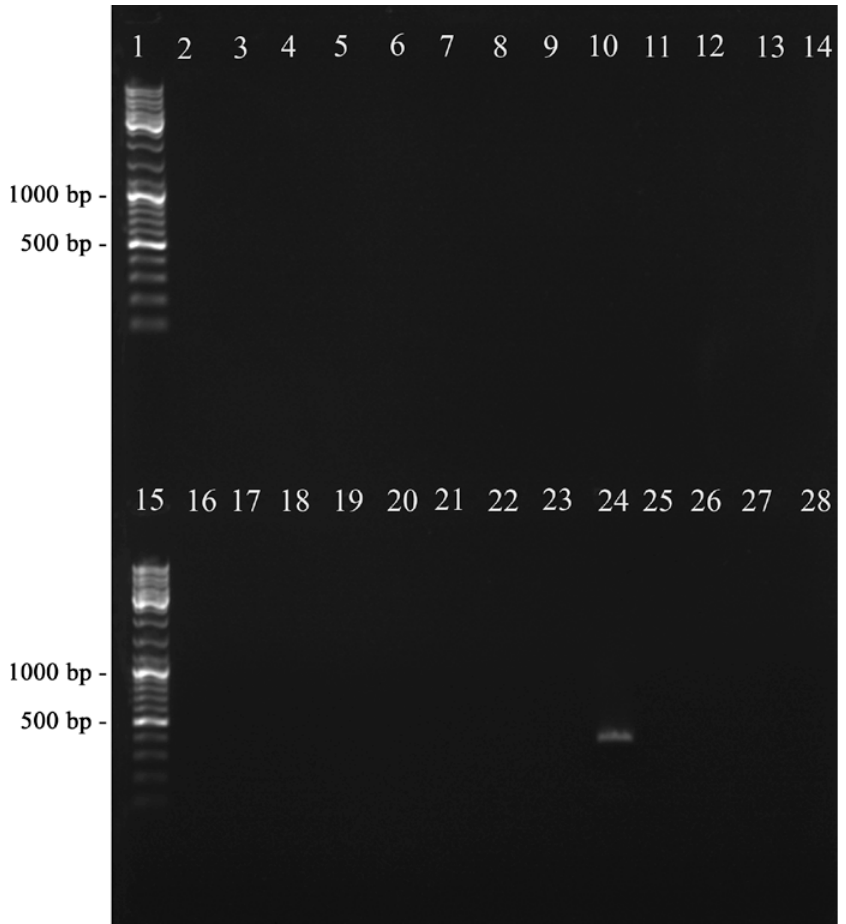
Figure 1. Gel electrophoresis of various Phytophthora species after PCR with ITS-IF1 and ITS-IR1 primers. (1) 100 bp DNA ladder, (2) P. arecae , (3) P. asparagi , (4) P. botryose , (5) P. cactorum , (6) P. cambivora , (7) P. capsici , (8) P. cinnamomi , (9) P. citricola , (10) P. citrophthora , (11) P. cryptogea , (12) P. drechsleri , (13) P. erythroseptica , (14) P. gonapodyides , (15) 100 bp DNA ladder, (16) P. inundata , (17) P. katsurae , (18) P. meadii , (19) P. medicaginis , (20) P. melonis , (21) P. nicotianae , (22) P. palmivora , (23) P. parsiana